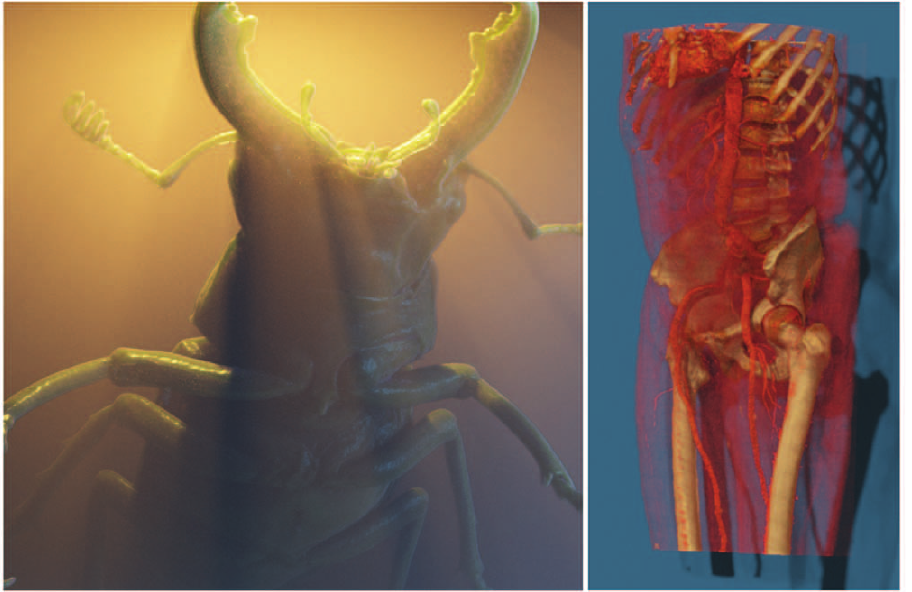
Figure 8. Left: Our method deals well with thin participating media. Right: Integration of physically based surface and volumetric scattering functions.